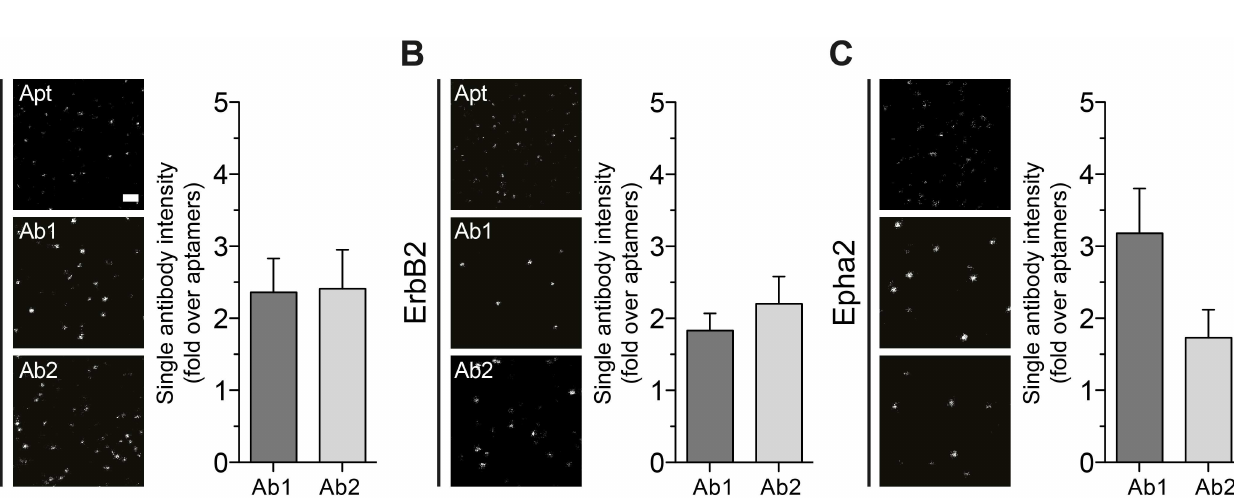
Fig 4. Average intensity of single antibodies and aptamers. (A-C) Examples of comparable STED images with single aptamers or single antibody packages(primary-secondary) seeded on glass coverslips. Scale bar (top image on panel A) represents500 nm. The plots associated display the averageintensity from more than thousandspots of single antibodypackagesexpressedas fold of single aptamer intensity. Error bars are the SEM of 3 independent experiments.